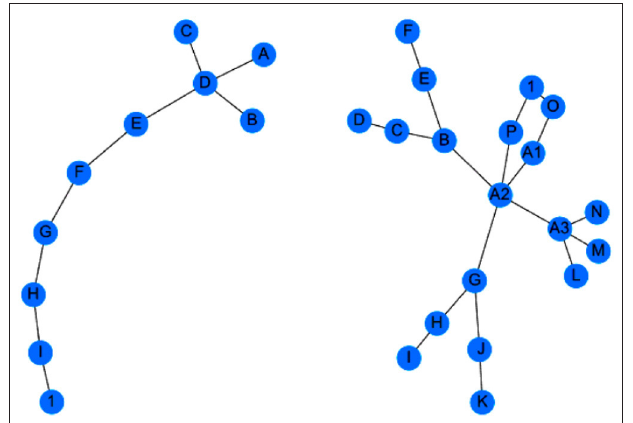
FIGURE 10 | Graph models for two structures: a wind turbine (left) and an airplane (right) .